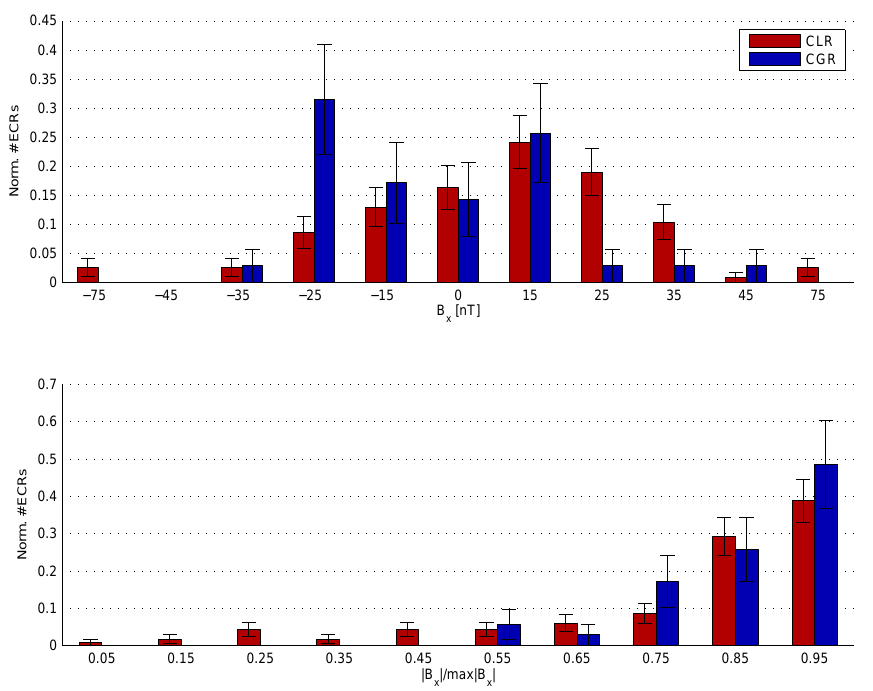
Fig. 7. The median value of the Earthward magnetic field, B x , within an ECR and the ratio | B x | / max | B x | can be used for investigating the closeness to the neutral sheet. As for the previous figures, red correspond to CLRs and blue to CGRs. The error bars indicate the uncertainty due to limited statistics. The plots are normalized so that the sum of all red bars is equal to one, and similarly for the blue bars. The ratio | B x | / max | B x | is used for estimating the variation and smallness of B x within the ECR. Small values correspond to larger variations in B x with possible excursions toward B x close to zero. Larger values of | B x | / max | B x | , on the other hand, indicate regions with smaller variations and where the median value of B x is rather close to the maximum value. The top panel shows that there is a tendency for CLRs to prefer smaller values of B x , with a peak around 15nT, while the CGRs show a double peak, at about − 25nT and 15nT. Although the evidence is not very strong, possibly because of limited statistics, the CLRs appear to be located closer to the neutral sheet than the CGRs. In the bottom panel the accumulation of CGRs toward larger values of | B x | / max | B x | is slightly more pronounced, supporting the same conclusion.